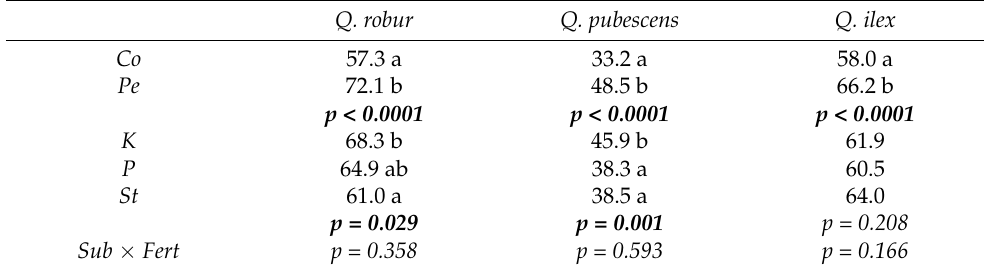
Table 3. Multifactorial ANOVA test results for seedlings height (cm) at T 0 (before the onset of water stress). Lowercase letters indicate homogeneous groups ( p ≤ 0.05). Pe , Co : peat and coir substrate; St , P , K : standard, P-and K-enriched fertilization. In bold significant